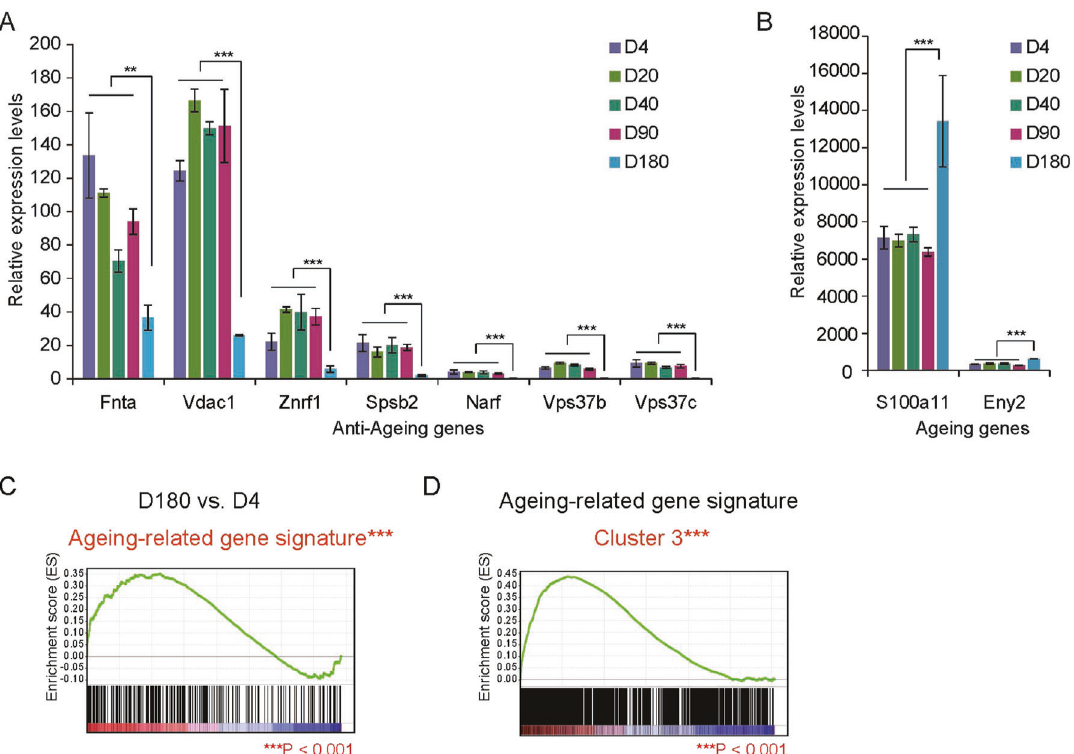
Fig. 6 Aging-related gene expression signature. A Decreased expression of the representative anti-aging genes including FNTA, VDAC1, NRF1, SPSB2, NARF, VPS37B, and VPS37C at D180, compared to D4. B Increased expression of the aging-promoting genes S100A11 and ENY2 at D180, compared to D4. C GSEA analysis revealed that DEGs in D180 vs. D4 are signi fi cantly enriched in an aging-related gene signature derived from GSE130472. D GSEA analysis showed upregulation of Cluster 3 genes in aged vs. young mice. DEG differentially expressed gene. Data are presented as the mean ± SEM ( n = 3). * p < 0.05, ** p < 0.01, *** p <